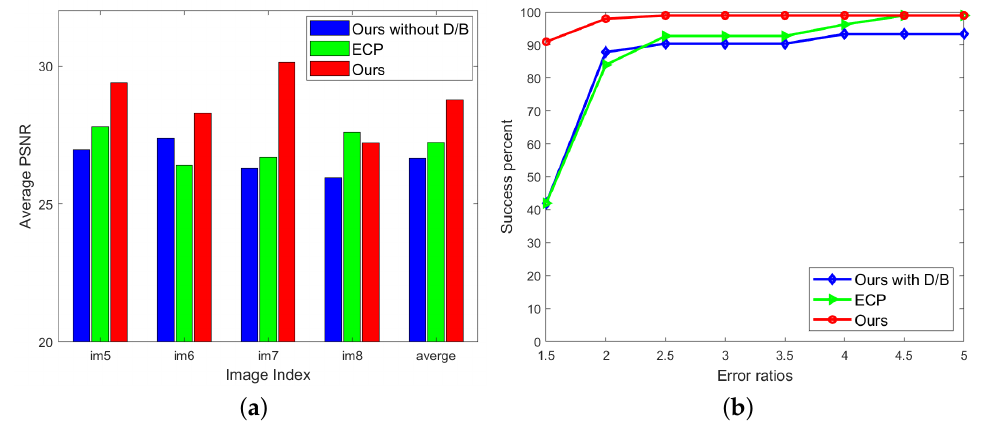
Figure 11. Quantitative results of our method on benchmark dataset [12]: ( a ) quantitative evaluations on the benchmark dataset by [12] and our method with and without D/B; ( b ) error comparison between our approach and the other